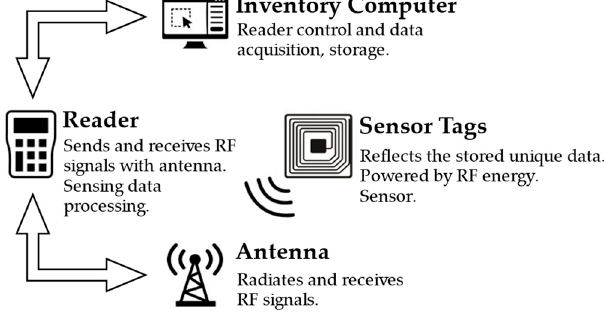
Figure 2. Basic RFID sensing system.